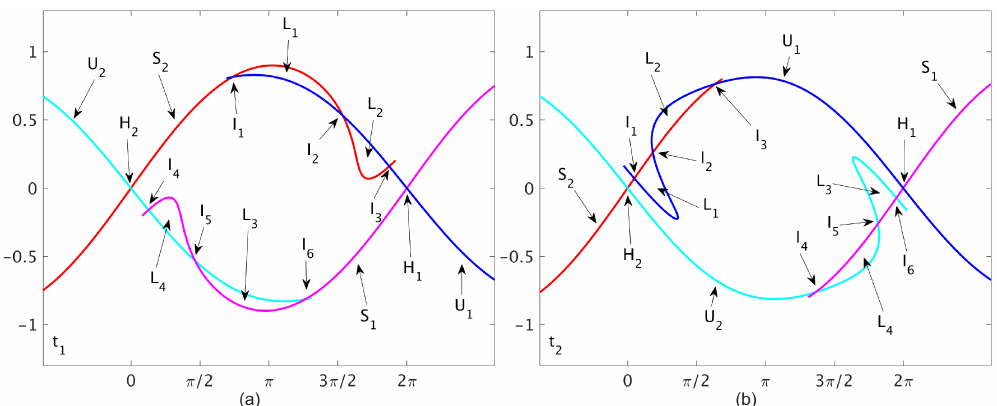
Figure 1. Diagram of lobe transport for a time-dependent cat-eye flow where the contents of the lobes are transported across the separatrix boundary formed by the unstable (blue and cyan) and stable (red and magenta) manifolds of a pair of hyperbolic trajectories. The lobes labeled L 1 and L 3 begin outside the cat eye and are transported to inside the cat